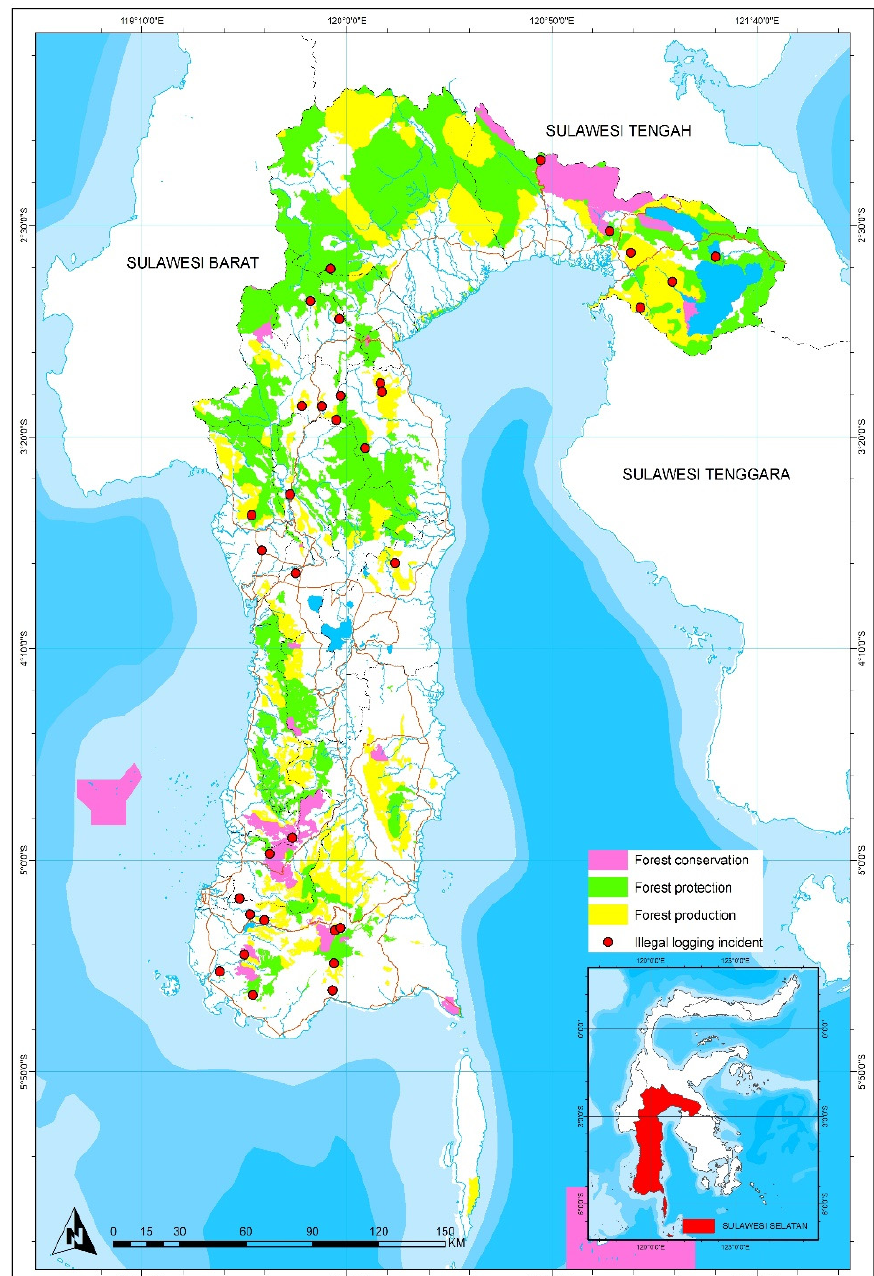
Figure 1. Research Figure 1. Research Llocation.